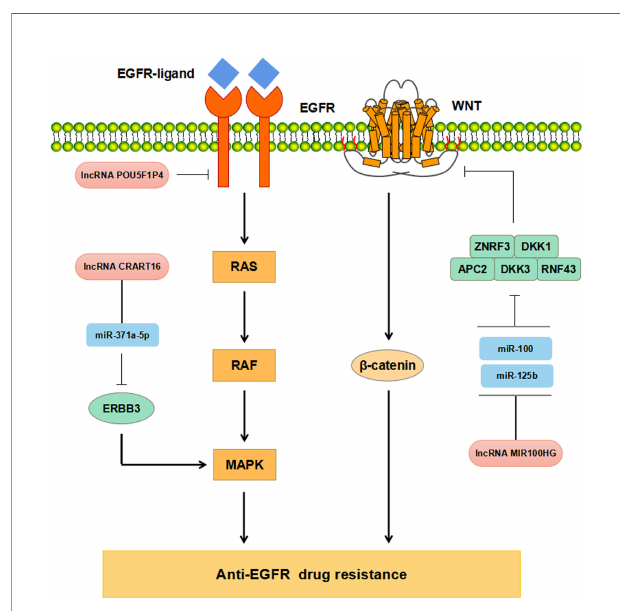
FIGURE 3 | Mechanisms of lncRNAs regulating anti-EGFR drug resistance in